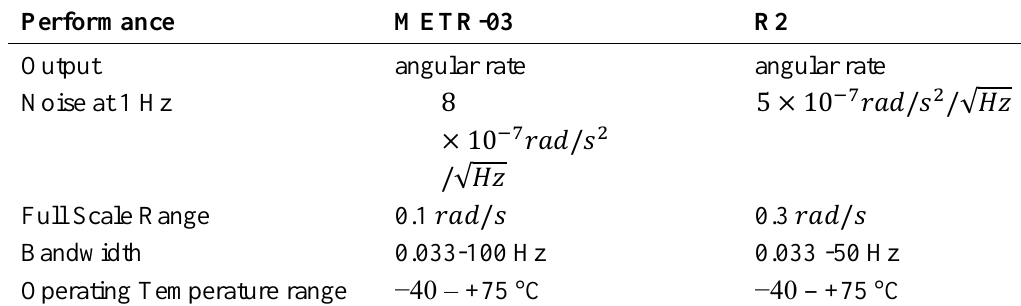
Table 2. Current performance parameters for MET rotational